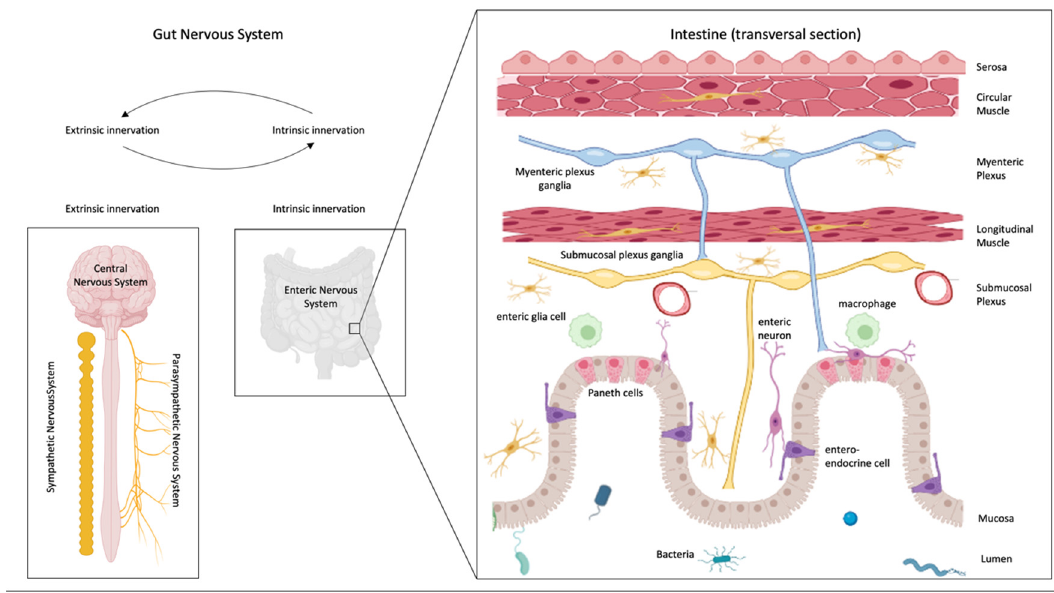
Figure 2. Gut nervous system. Intestine is heavily innervated by an intrinsic dense neural network (intrinsic nervous system) and by an extrinsic nervous system formed by the sensory and motor nerves of the central, sympathetic, and parasympathetic nervous systems. The enteric nervous system is composed of two complex neural plexuses, the myenteric, lying between the two muscles of the intestine, and the submucosal, placed between the longitudinal muscle and the mucosa. There is bidirectional communication between the intrinsic and the extrinsic system, and both of them communicate/interact with bacteria and immune system cells.